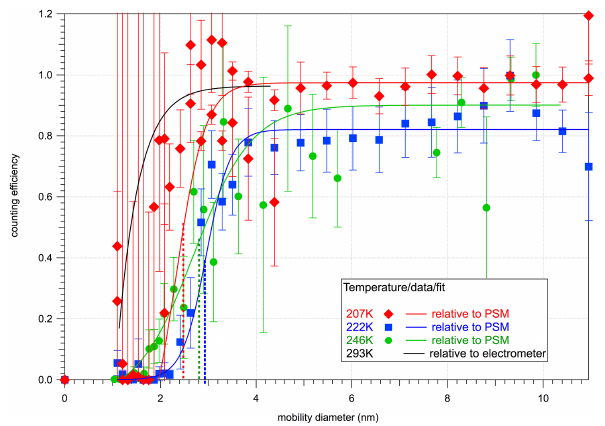
Figure 3. Results from calibration measurements. The blue, green and red curves show fits to the results from calibration measure- ments for the DEG-CPC 1, done at CLOUD in autumn 2011 and the symbols show the measured data points at three different tem- peratures (246.25, 222.65, 207.15K). Black curve shows laboratory calibrations (Wimmer et al., 2013) using negatively charged ammo- nium sulfate clusters. The d 50 relative is shifted from about 1.4nm at room temperature (relative to an electrometer) to 2.5nm in the case of 207.15K about 2.6nm for 246.25K, and for the 222.65K the cut-off is shifted to 2.8nm. To illustrate the values for the cut- offs, dashed lines pointing to the according sizes are added to the figure. Due to low statistics, the y axis error bars are rather large. The error, resulting from the finite width of the transfer function of the nano-DMA used for the low temperature calibration mea- surements, is 0.185 at 1.47nm, 0.158 at 1.78nm and 0.14 at 3nm according to Jiang et al.